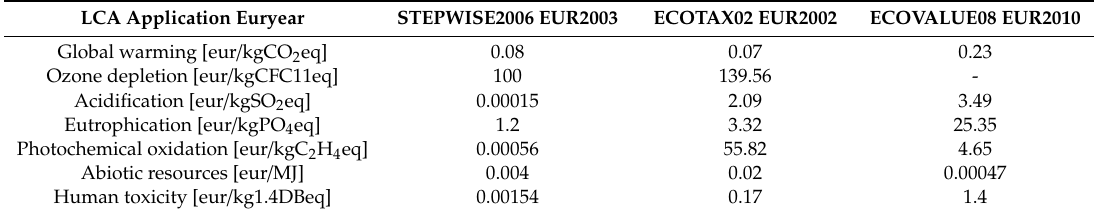
Table 3. Shadow prices used in di ff erent monetary valuation methods